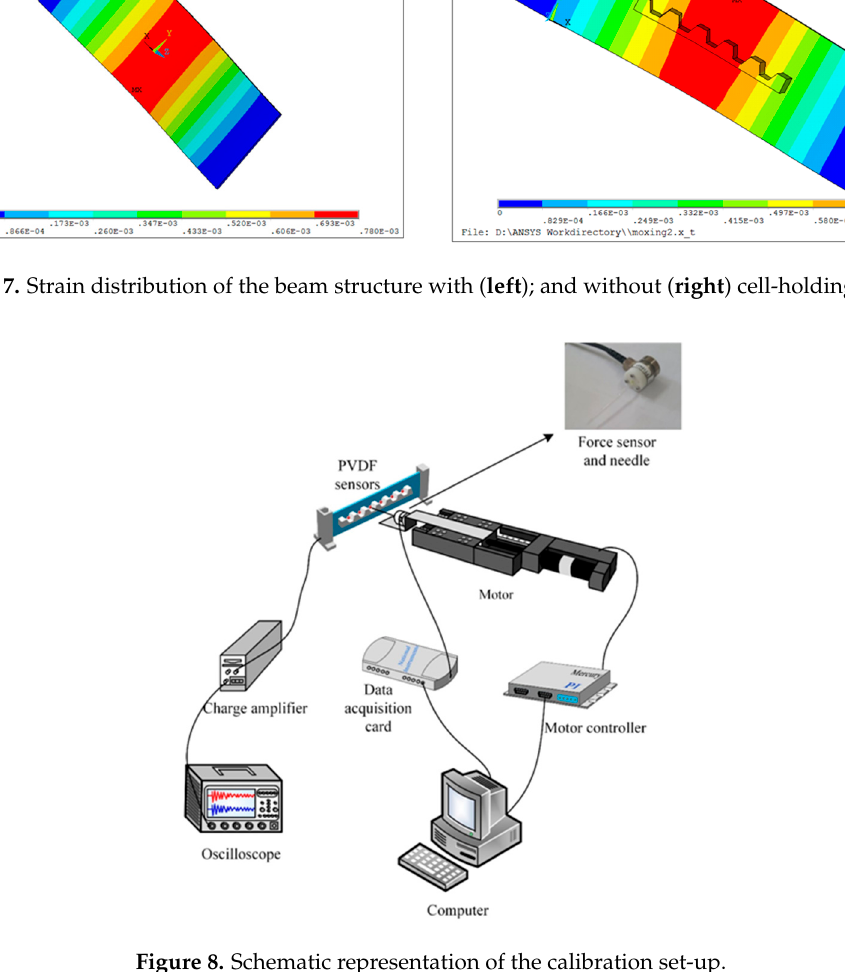
Figure 8. Schematic representation of the calibration set-up.